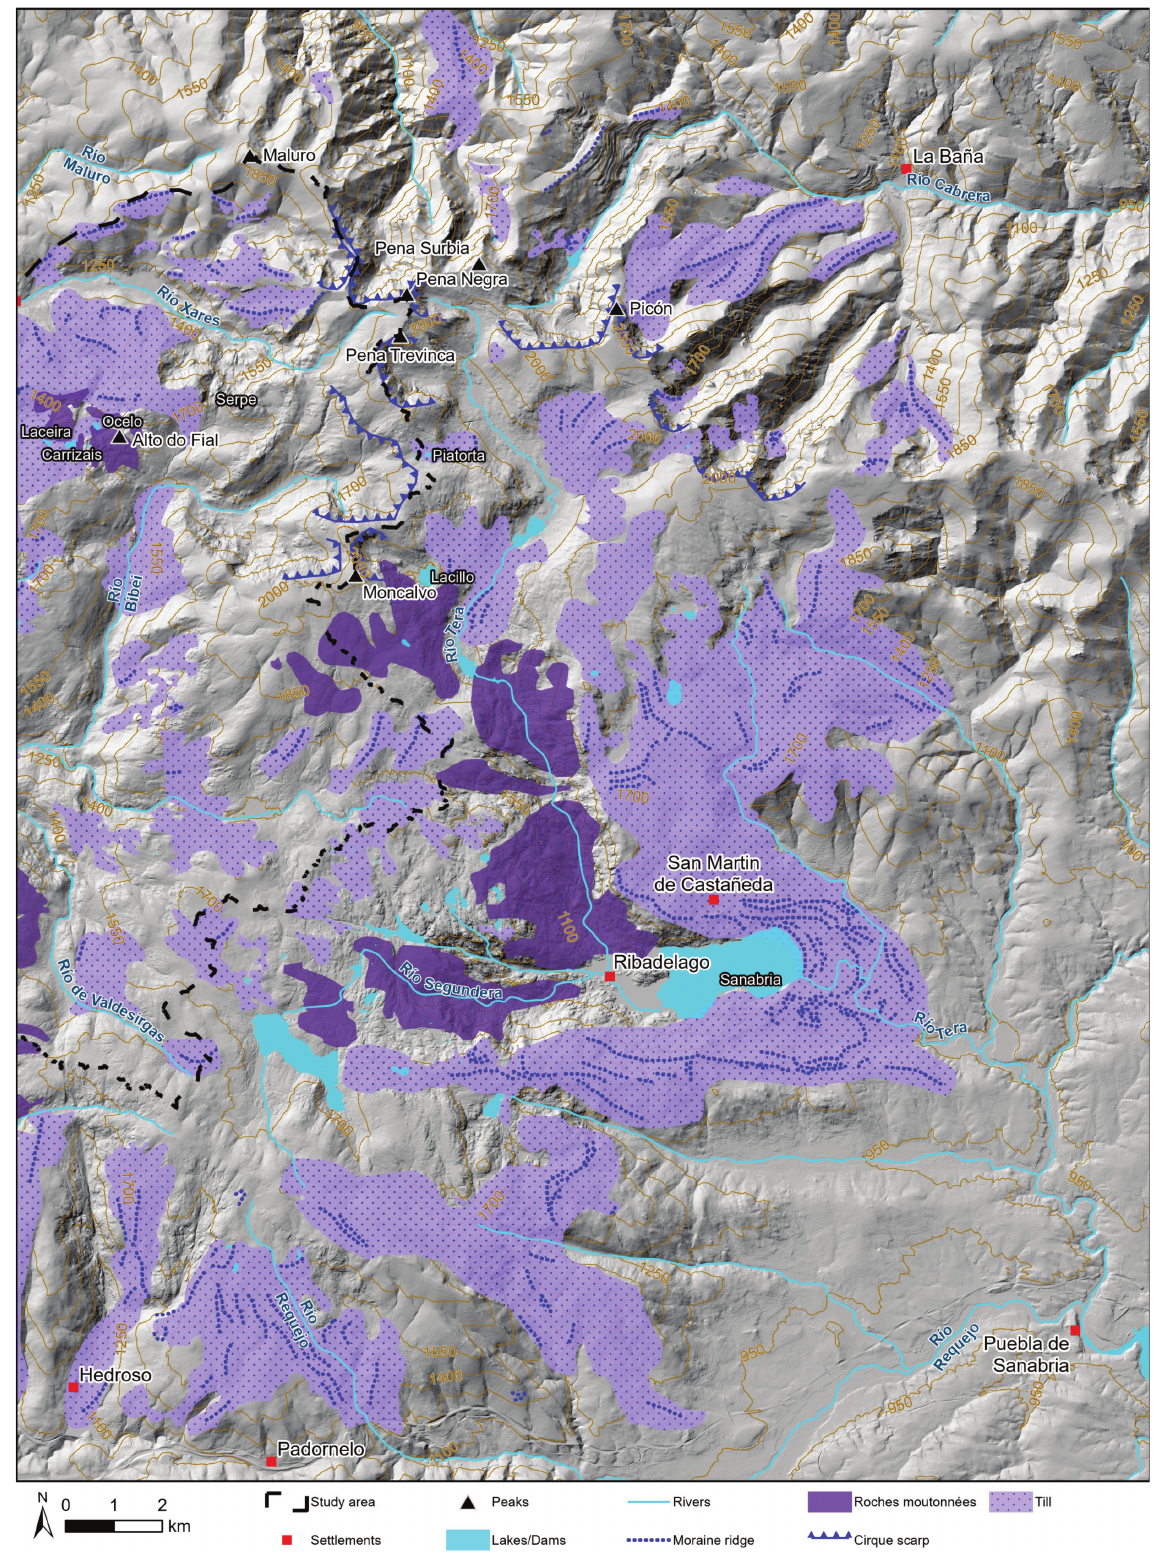
Figure 6. Map of glacial landforms at the oriental Trevinca Massif sector. Location in Figures 1 and